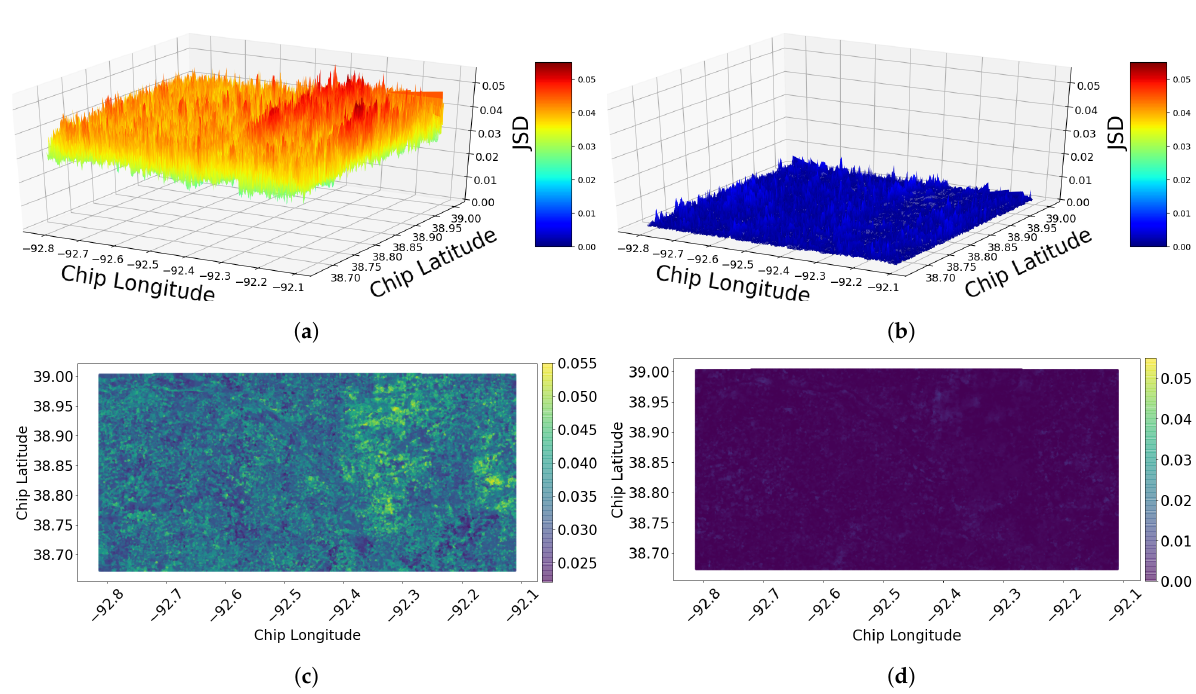
Figure 9. Jensen–Shannon divergence (JSD) of the change based on the chip-level utilizing neighborhood method of (1-N) during two different time periods: ( a ) 3D (2011–2015). ( b ) 3D (2015–2017). ( c ) 2D (2011–2015). ( d ) 2D (2015–2017).